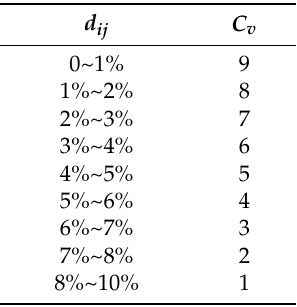
Table 2. Correspondence between deviation range and C v value.